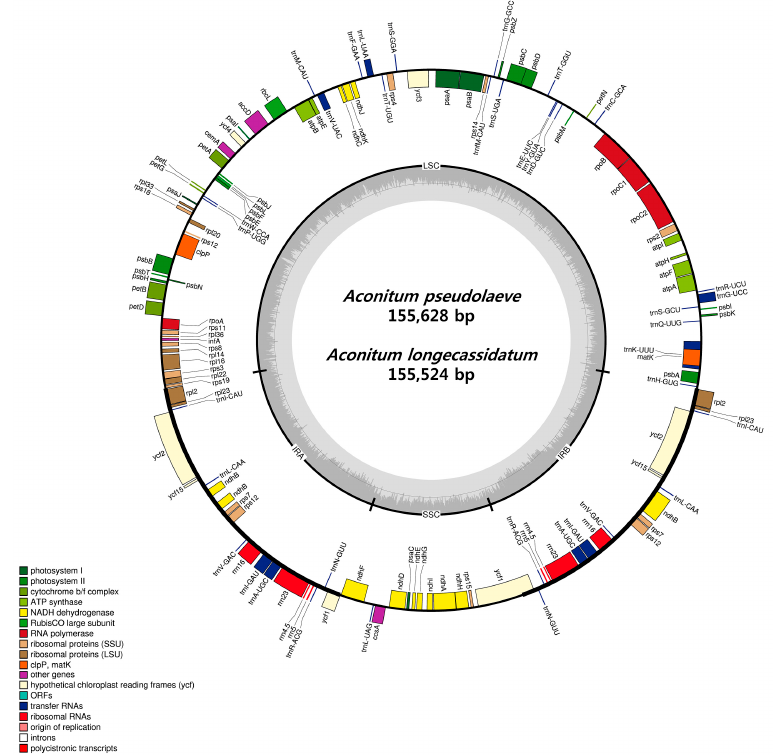
Figure 1. Circular gene map of A. pseudolaeve and A. longecassidatum . Genes drawn inside the circle are transcribed clockwise, and those outside the circle counterclockwise. The darker gray in the inner circle represents (GC) content. The gene map corresponds to A. pseudolaeve . LSC: large single copy; IR: inverted repeat; SSC: small single copy; GC: guanine-cytosine; ORF: open reading frame .